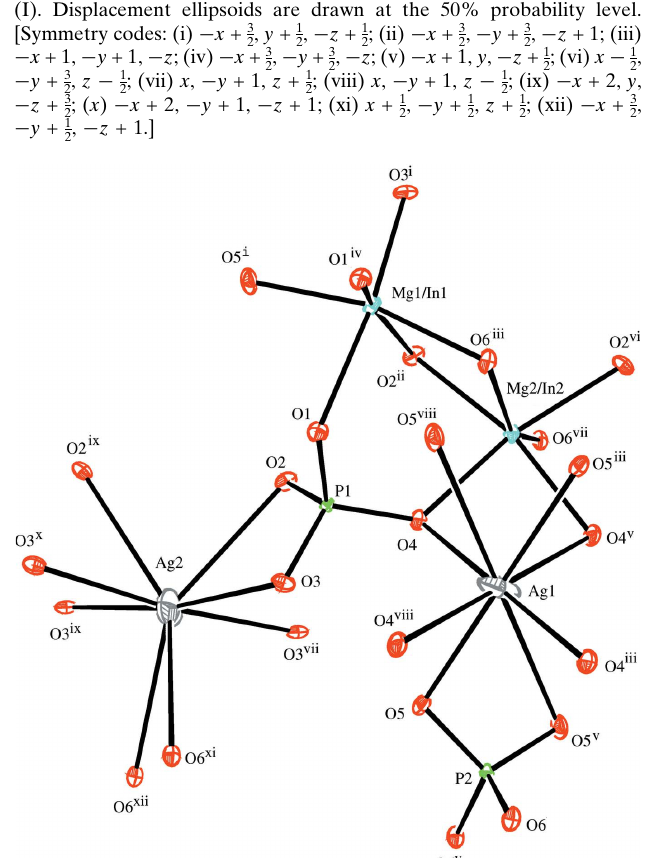
Figure 2 The principal building units in the structure of Ag 1.69 Mg 1.69 In 1.31 (PO 4 ) 3 , (II). Displacement ellipsoids are drawn at the 50% probability level. Symmetry codes are as in Fig. 1.